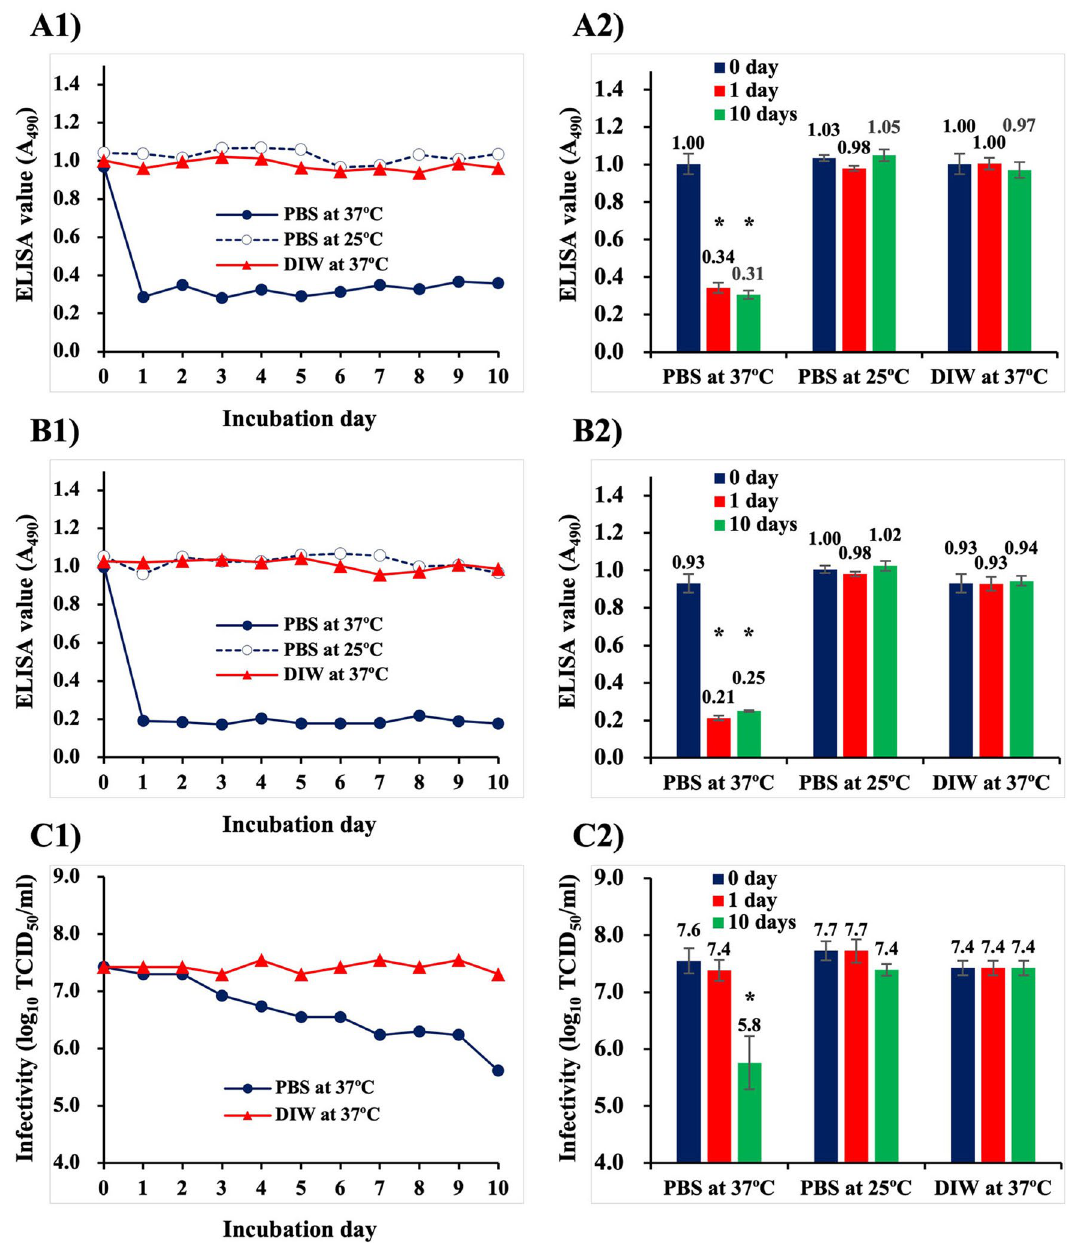
Figure 1. Alteration in antigenicity and infectivity of purified NNV particles after incubation at 37 °C in PBS. Purified NNV particles were incubated in PBS at 37 °C or at 25 °C, and in DIW at 37 °C for 10 days. ( A ) Alteration of NNV antigenicity detected with ELISA using anti-NNV PAb, ( B ) ELISA detection using anti-NNV MAb, ( C ) Alteration of NNV infectivity. (1) Results of a single set of experiments using the same sample on the same day. (2) The same experiments were conducted five times on different days, but limited to 0, 1 and 10 days incubation. Error bars indicate standard deviation (SD). *: Significant difference (ρ < 0.05) compared to the values on day